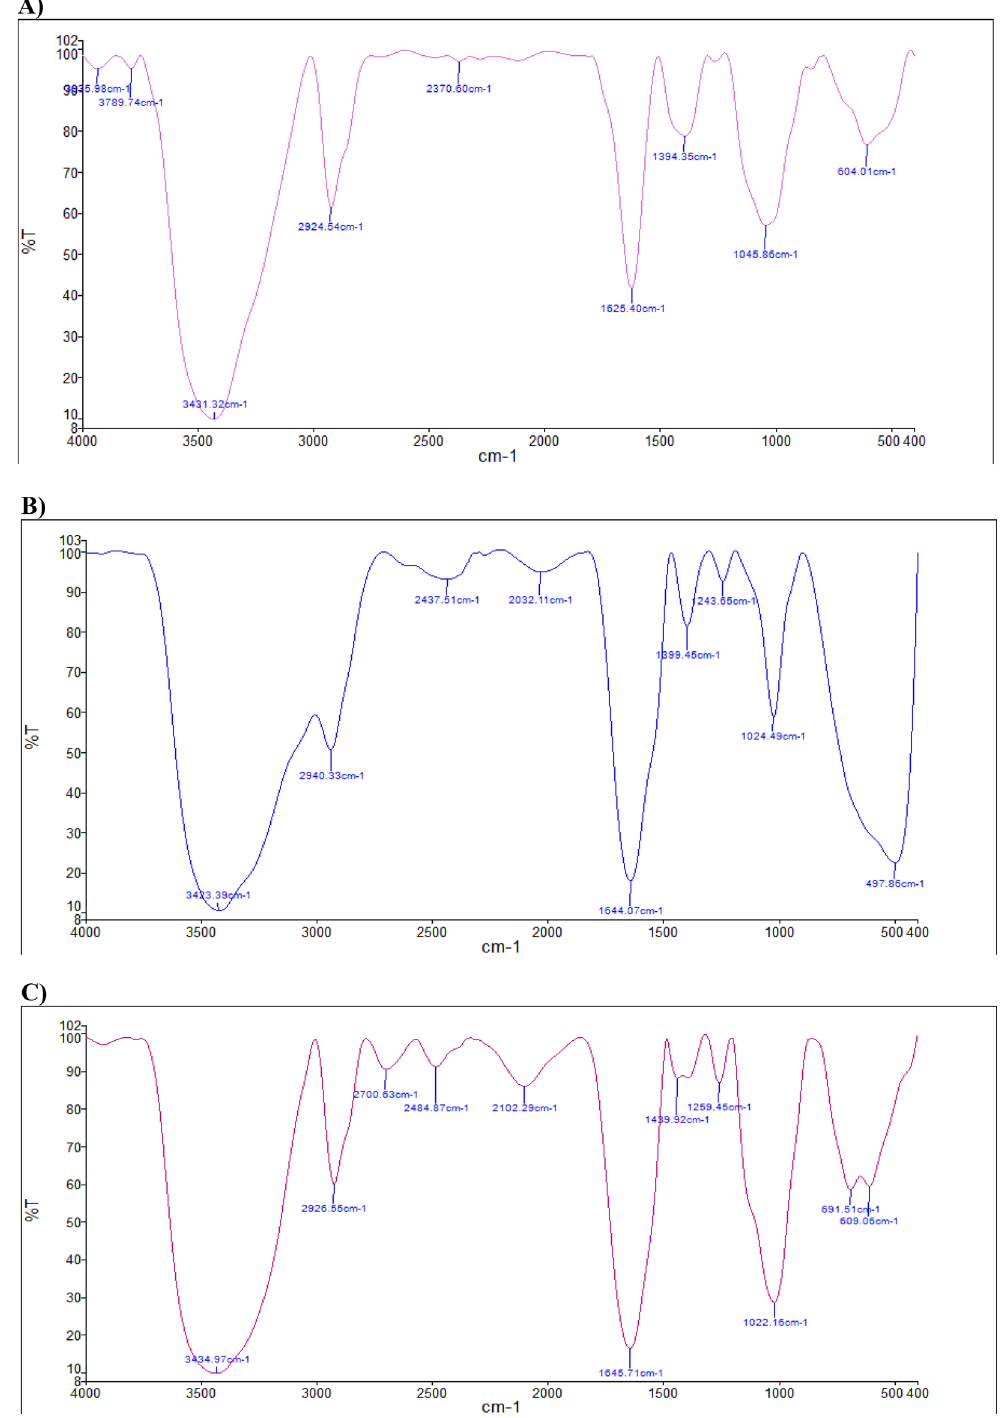
Figure 2. FTIR, Mapping, and EDAX structural analyses. ( A ) PA-OMVs, ( B ) DT, and ( C ) PA-OMVs-DT structures analyzed by FTIR. ( D , E , and F ) structures analysis of PA-OMVs, DT, and PA-OMVs-DT by Mapping analysis. ( G and H ) structural analysis of the PA-OMVs, and PA-OMVs-DT by